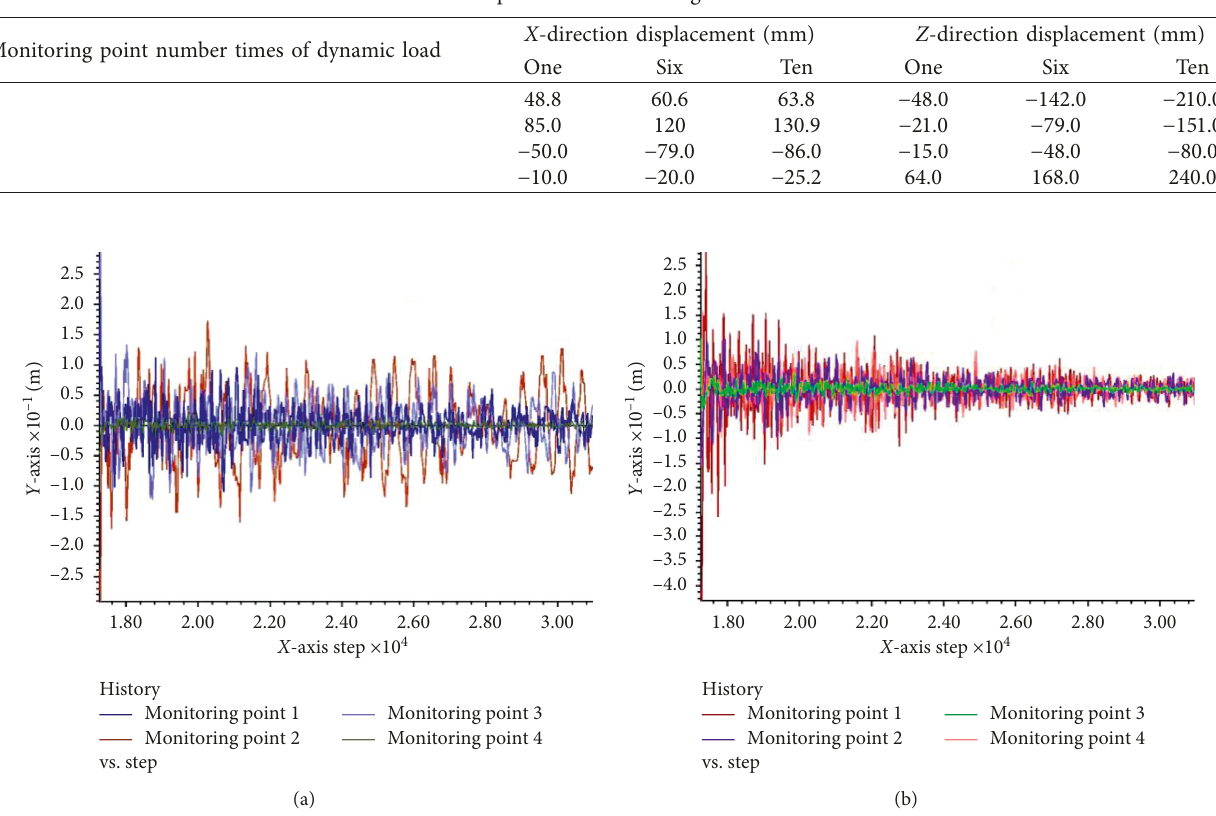
Figure 8: Deformation velocity response diagrams for one dynamic load. (a) X -directional deformation velocity and (b) Z -directional deformation